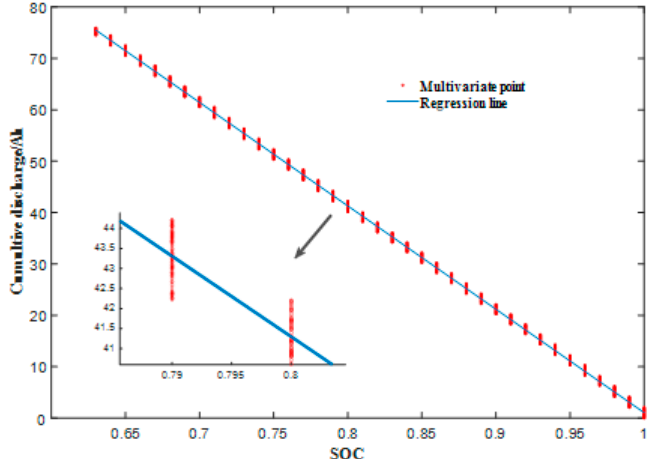
Figure 7. Multiple point linear regression.